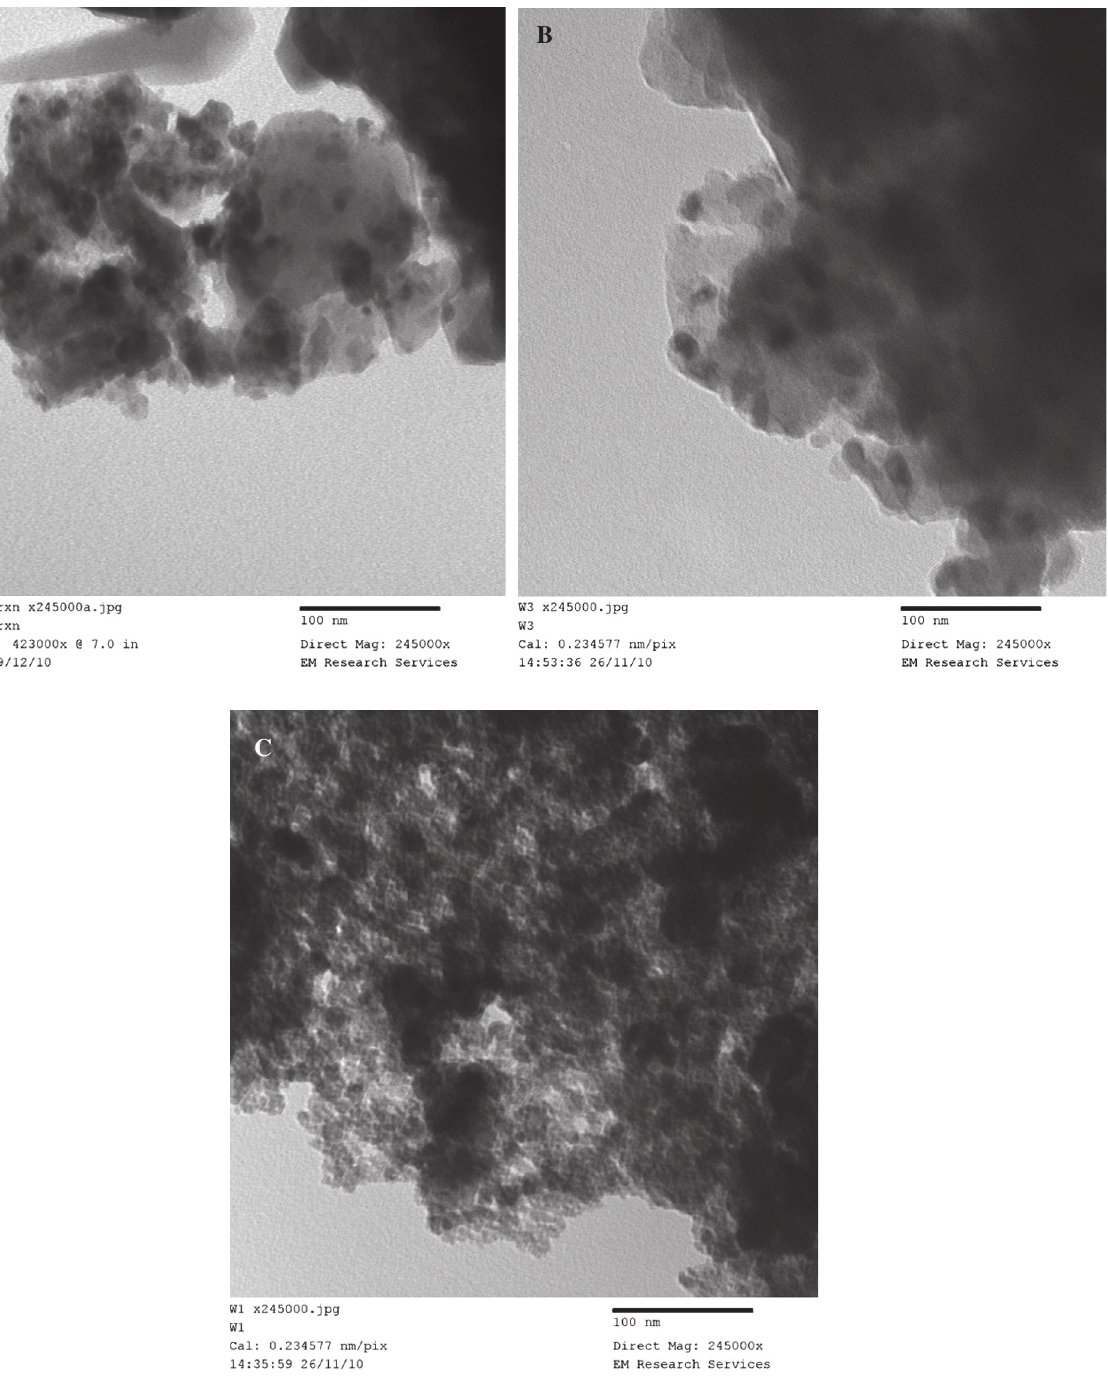
Figure 4 TEM images of supported Cu/Co catalyst samples. (A) Fresh catalyst; (B) catalyst used in conventional FTS; and (C) catalyst used in plasma-assisted